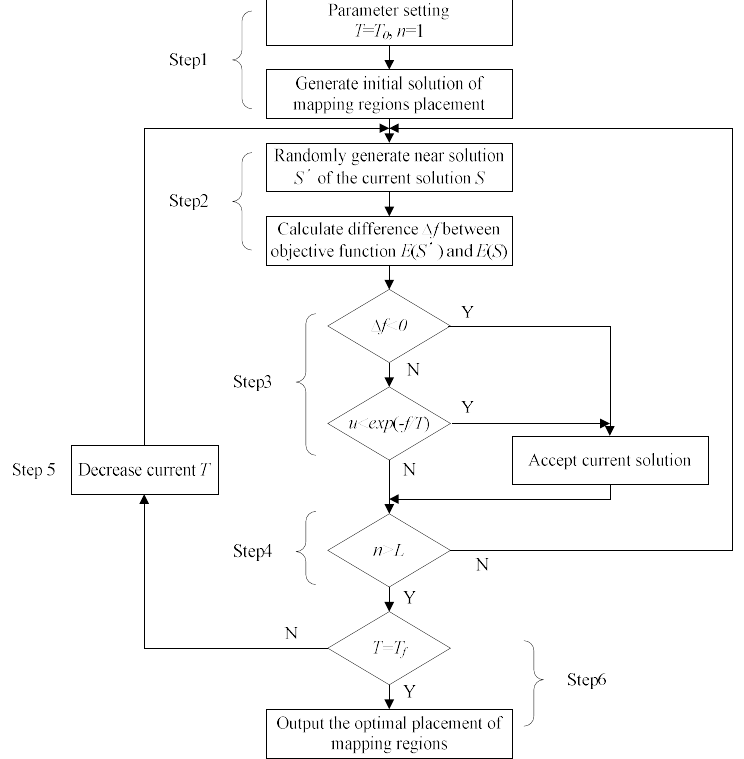
Figure 3. The optimal placement of the application mapping regions generated using